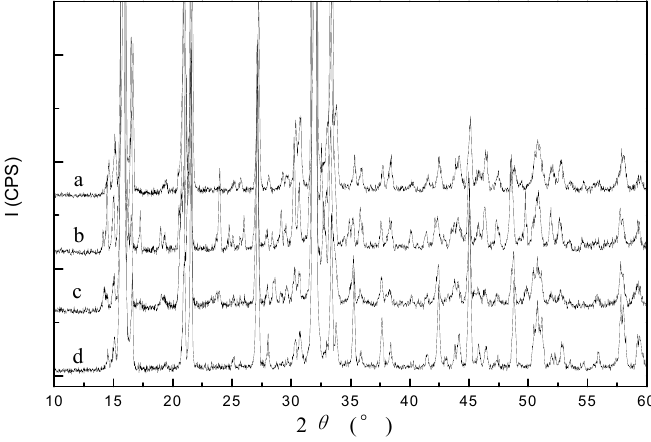
Figure 2. XRD diffractograms of precipitates for four chosen chemical combinations at pH 9 and a Mg 2+ :NH 4+ -N:PO 43 − -P molar ratio of 1:1:1, ( a ) Na ( b ) NaH PO ·12H O + MgCl 2 4 2 MgCl ·6H O. 2 2